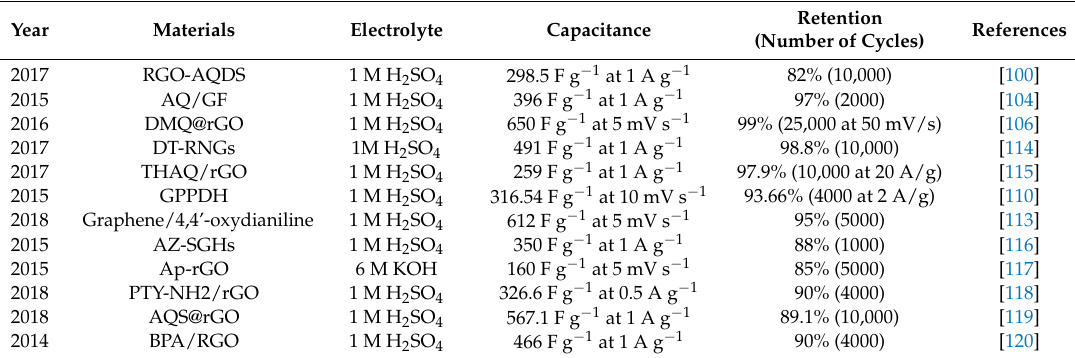
Table 1. Performance of organic molecule/graphene composite